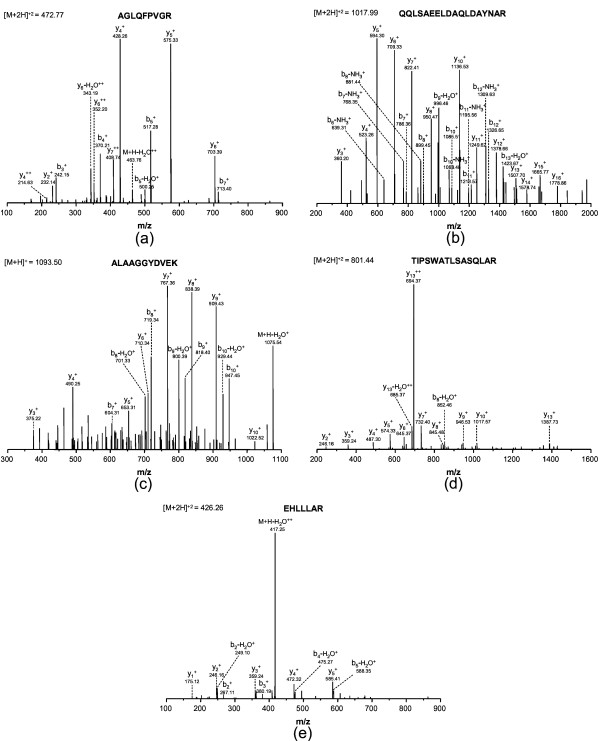
Examples of spectral influences on scoring. High quality data for peptides of short (a) and long (b) lengths. Poorer quality data from a low signal-to-noise spectrum (c), a spectrum from a peptide with a single dominant product ion due to fragmentation at the N-terminal side of Pro (d) and a spectrum of a peptide with a single dominant product ion due to a extensive neutral loss of water at the N-terminal Glu (e) [30].